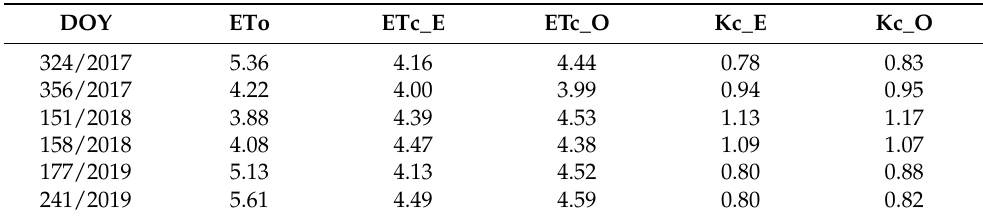
Table 4. Reference evapotranspiration (ETo), crop evapotranspiration (ETc), and single crop coefficient (Kc) estimated by SEBAL and observed in